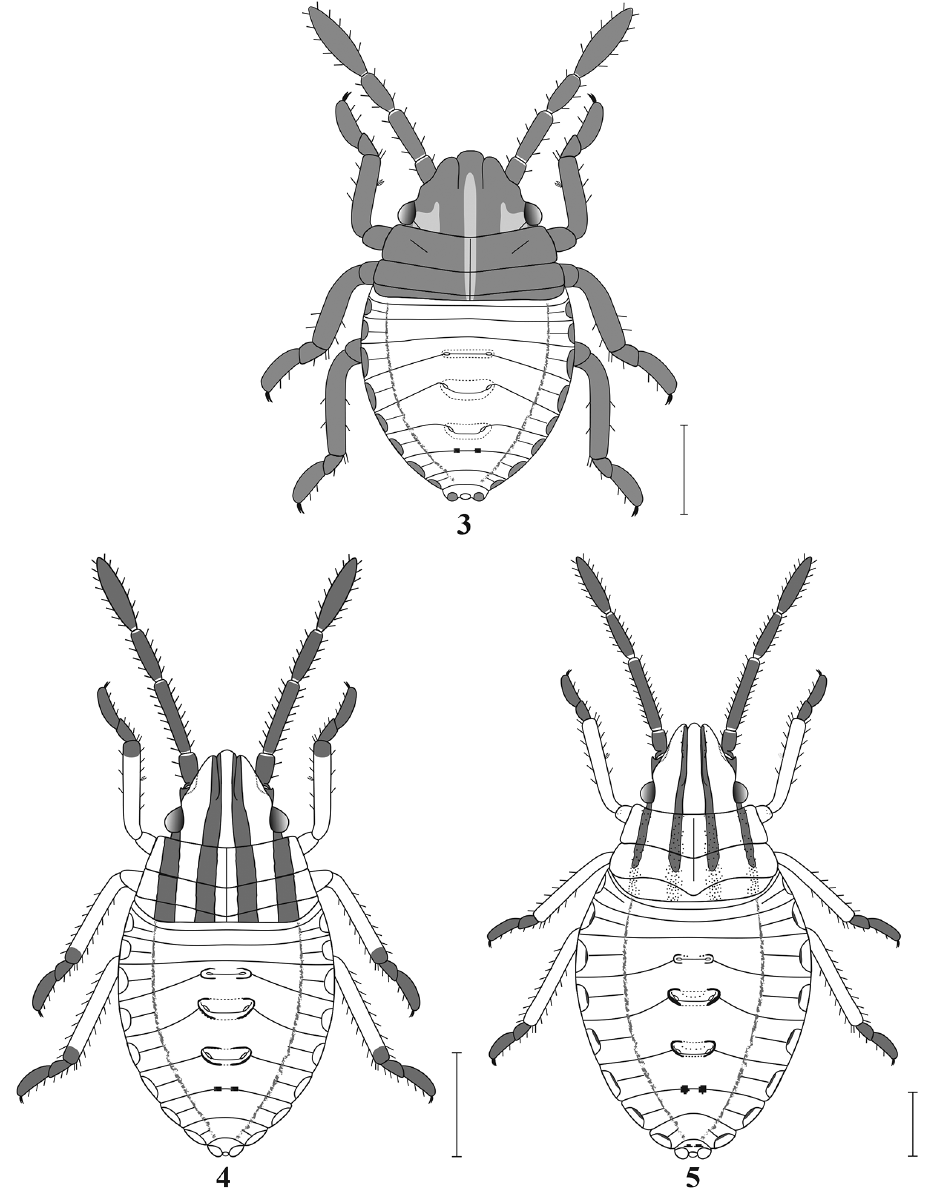
Figures 3–5. 3 First instar of M. major (dorsal view) 4 Second instar of M. major (dorsal view) 5 Third instar of M. major (dorsal view). Scale bars: 0.5